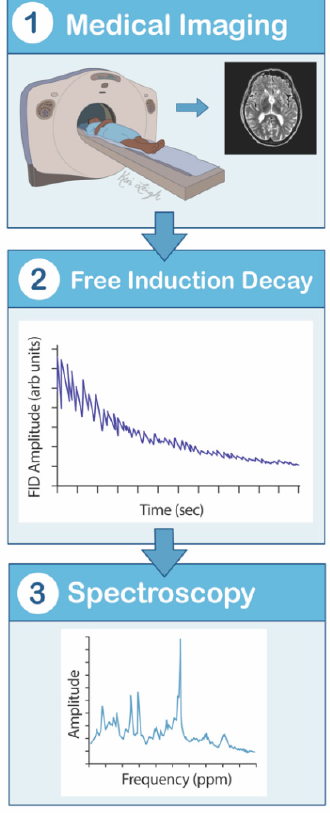
Figure 5. Magnetic resonance spectroscopy mechanism flowsheet. (1) The patient lies supine in the MRS scanner. (2) The hydrogen nuclei contain a nonzero intrinsic quantum mechanical spin of the protons and neutrons, which is manipulated by magnetic fields. Magnetization is applied, creating an observed nuclear magnetic resonance signal. Frequencies are then detected by a radiofrequency coil placed near the brain, creating a free induction decay. (3) The electromagnetic force that is generated is proportional to the magnitude of magnetization, and this proportion allows the MRS to provide spectra of the signal source. MRS is a magnetic resonance spectrum that graphically displays detected signals as a function of temporal frequencies. MRS—magnetic resonance spectroscopy.